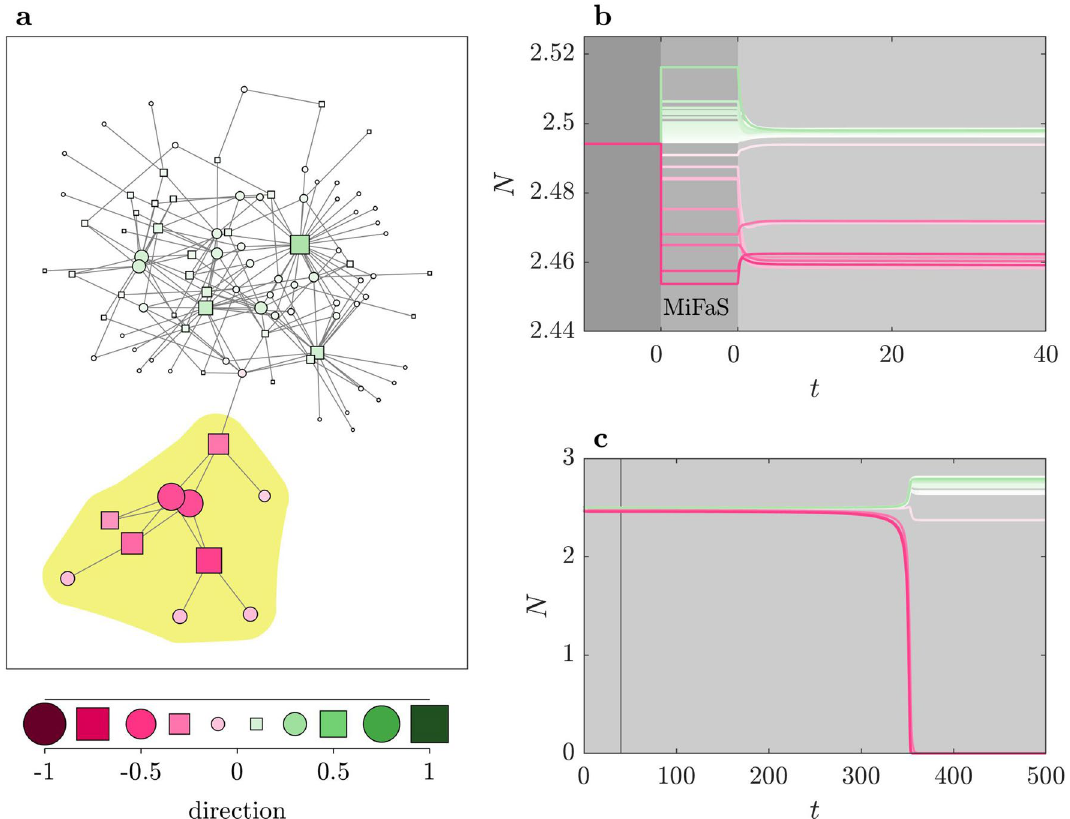
Figure 2. Minimal Fatal Shock for an exemplary plant–pollinator network. ( a ) Direction of the MiFaS. The perturbation vector is scaled to a length of 1. The relative contribution of each element of the vector (node in the network) to the overall perturbation is represented by the area and the color saturation of the respective squares and circles. A pink coloring denotes a loss and a green coloring a gain in species abundance at the respective node. Squares portray pollinators and circles plants. Species being lost after the perturbation are marked by the yellow shaded region. Placement of the vertices is based on the Kamada–Kawai algorithm 66 obtained from python-igraph version 0.7.1 (https ://igrap h.org/). ( b ) Transient behavior following the MiFaS. Dark gray area shows the situation before the perturbation (desired state). Lighter gray area shows how the state variables are altered due to the perturbation. Light gray area depicts the transient behavior after the system has been perturbed. ( c ) Evolution over a longer time span. Vertical line displays the time interval shown in ( b ). The figure was generated using MATLAB version R2020a (https ://www.mathw